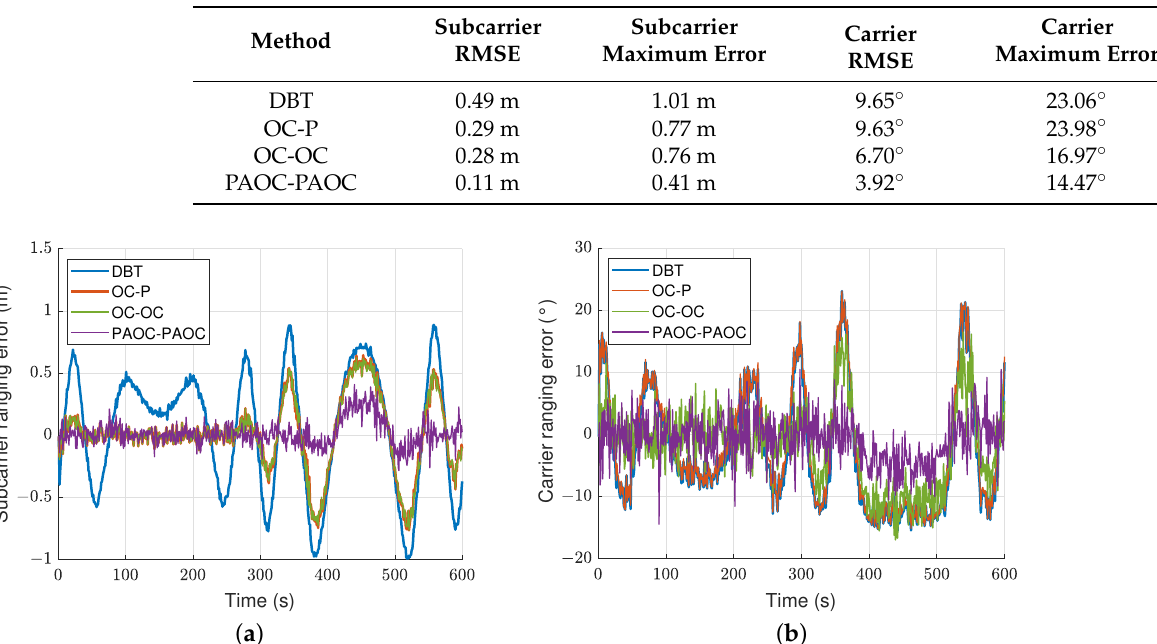
Table 4. Ranging errors of the four methods for the BOC(15, 2.5) signal in the dynamic multipath scenario.